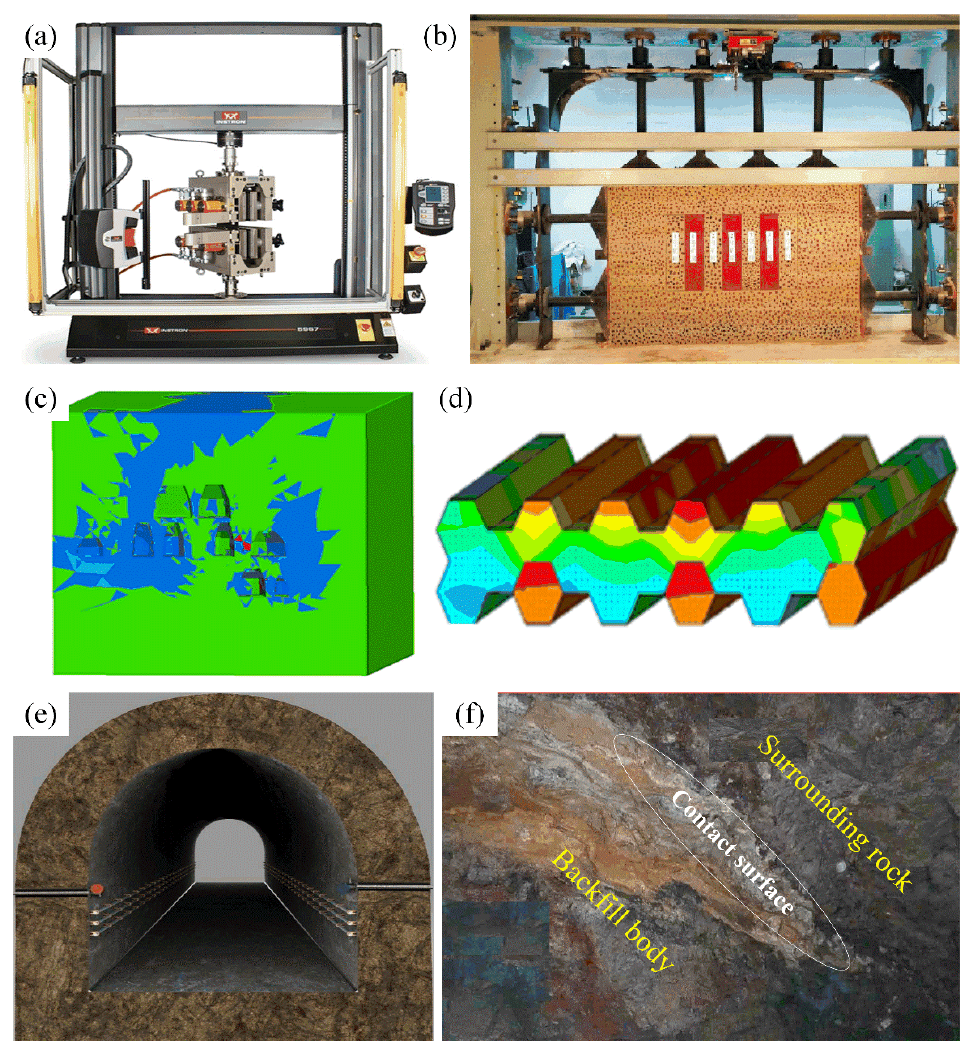
Figure 9. Backfill effect evaluation: ( a ) Filling body compression test; ( b ) Similarity model test; ( c ) Numerical simulation analysis of goaf; ( d ) Stope stability analysis; ( e ) Ground pressure detection; ( f ) Field industrial tests.